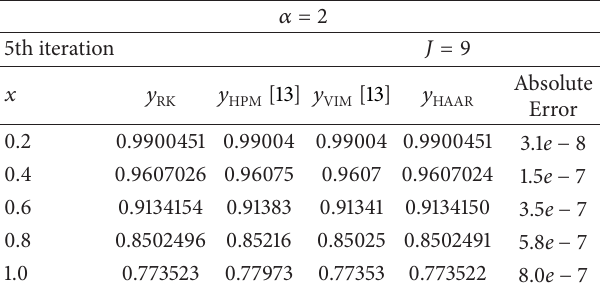
Table 1: Single-well situation: comparison of solutions by the Haar at 5th iteration and level wavelet-quasilinearization technique 𝑦 HAAR of resolutions 𝐽 = 9 with numerical methods [13] and numerical solution based on the fourth-order Runge-Kutta.